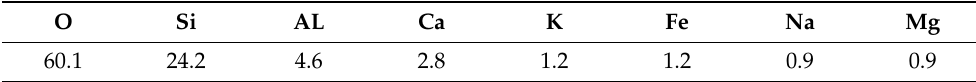
Table 3. Percentages of chemical composition.